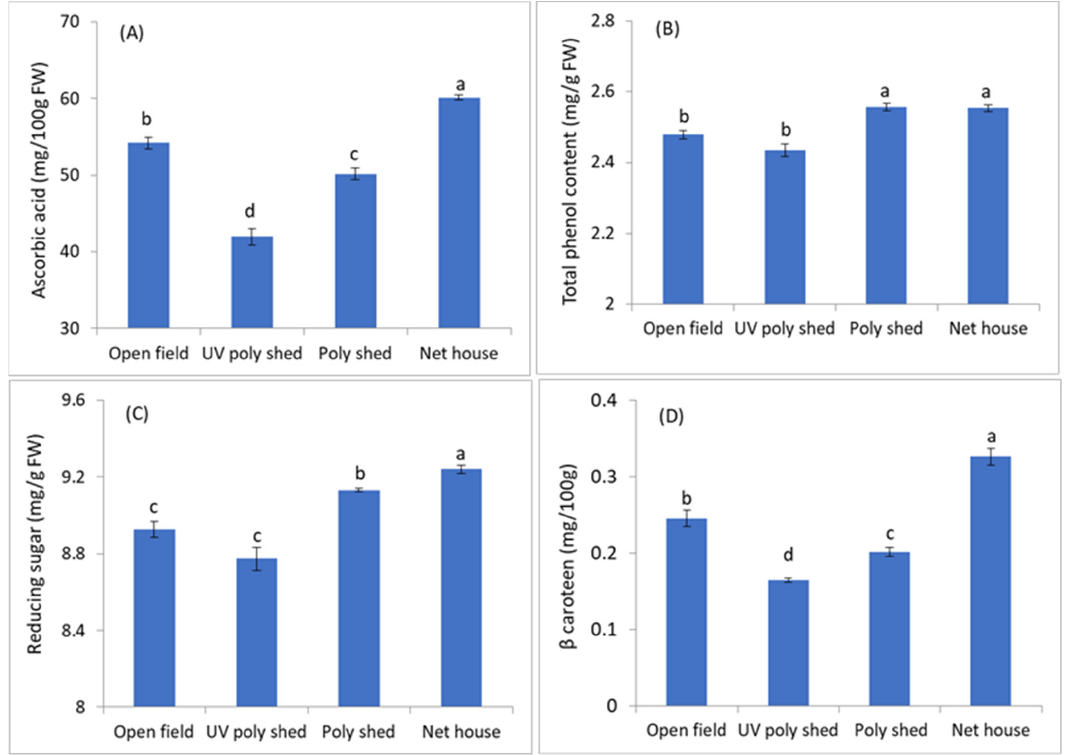
Figure 6. Average content of ascorbic acid (mg/100 g) ( A ), total phenol (mg/g FW) ( B ), reducing sugar (mg/g FW) ( C ) and β -caroteen (mg/100 g) ( D ) of papaya fruits grown under different sheds and open field condition. Mean ± Standard error (S.E.) (n = 15). Means with the same lower case letter are not significantly different at p = 0.05 by Duncan’s multiple range test.